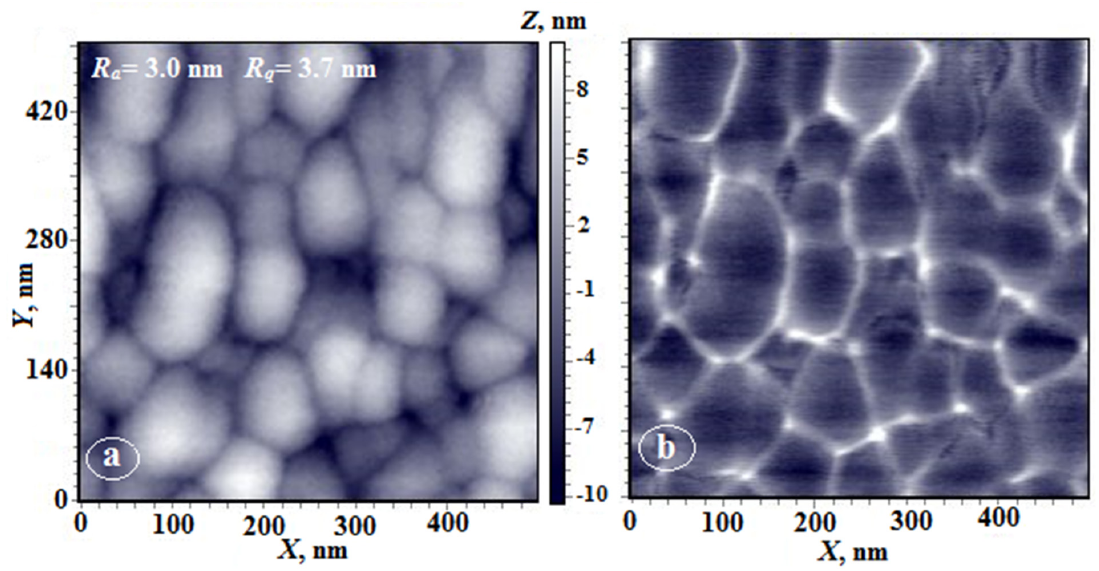
Figure 11. AFM images of the free (upper) surface of PAI-2 film ( a , b ); ( a )—height image, ( b )—phase contrast image.